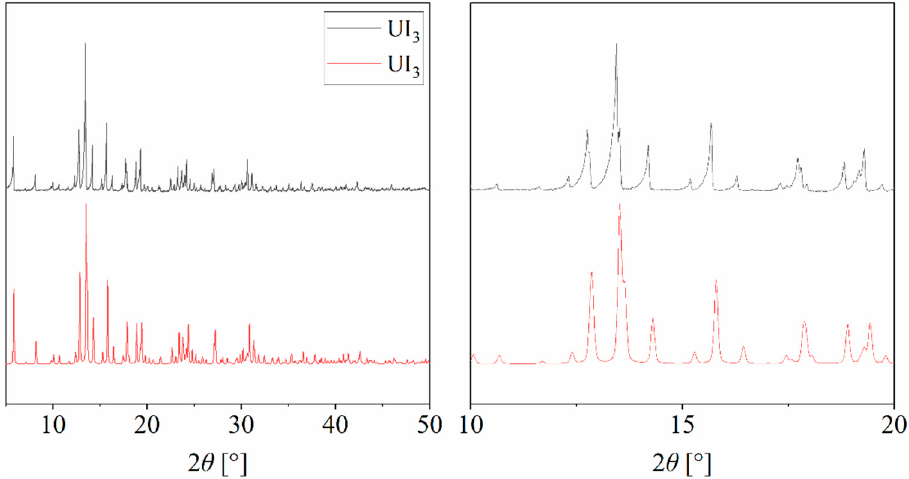
Figure 3. PXRD of UI 3 and calculated peak data [48].